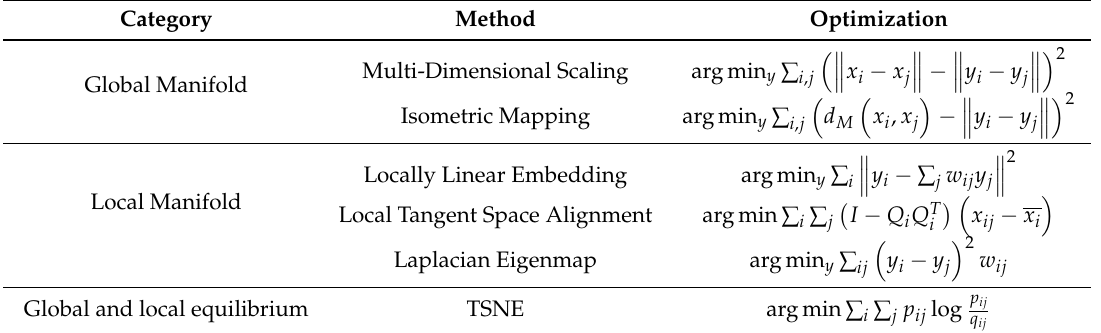
Table 1. Typical manifold methods classification.